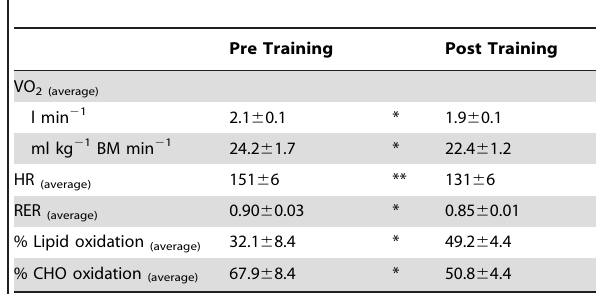
Table 2. Exercise performance